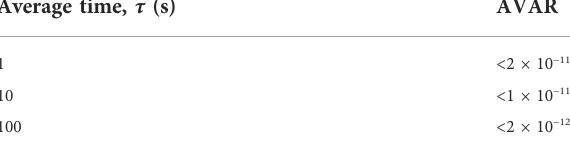
TABLE 3 Stability performance of the FS725 — benchtop rubidium frequency standard. Average time, τ (s)